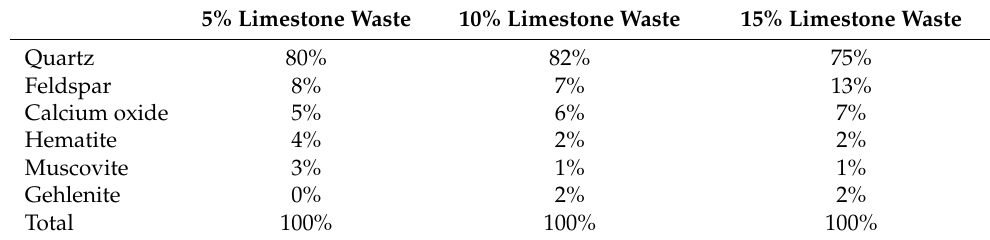
Table 2. Estimated concentration of present minerals.